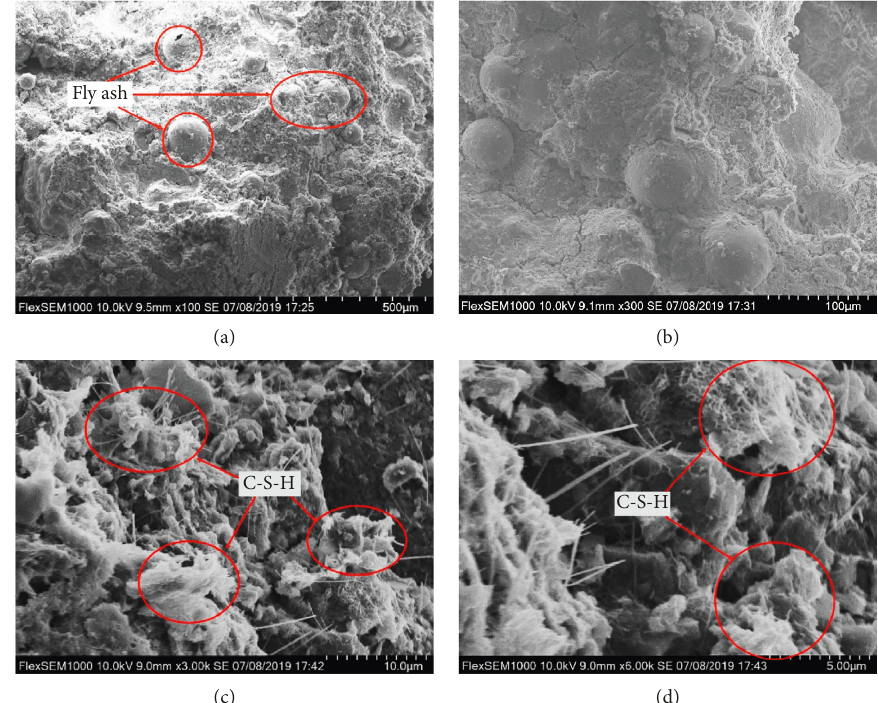
Figure 21: SEM images of 10% F+5% L-modified expansive soil under different magnification multiples (28days). (a) × 100; (b) × 1000; (c) × 3000; (d) ×